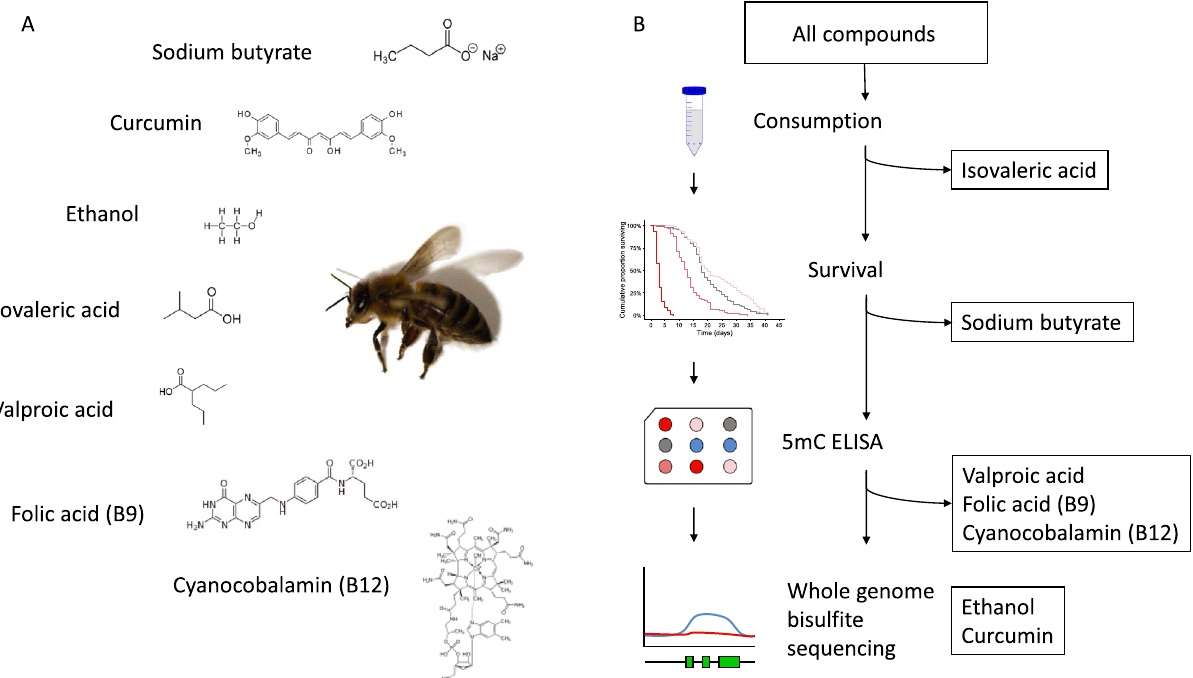
Figure 1. Overview of experimental setup. ( A ) Overview of the 7 initial compounds used. ( B ) Overview of flow of screening methodologies. A three-step screening approach was applied, were the 7 substances, at a range of concentrations, were first screened for effects on longevity. All substances and concentrations were assessed for any deviation in consumption, and only substances that did not affect food consumption were included in further analysis. These substances were then screened by ELISA for global methylation changes. The most promising candidate was selected for WGBS and in-depth analyses of how DNA methylation may be affected by substance